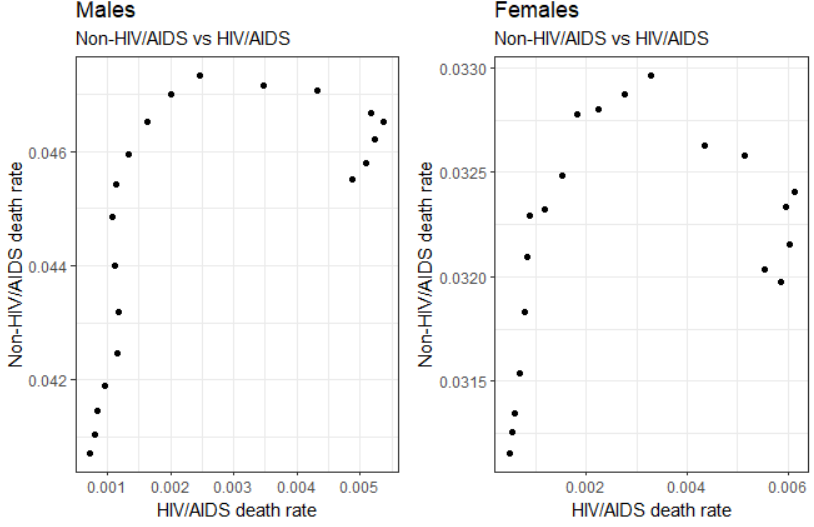
Figure 5. Joint distribution for non-HIV/AIDS and HIV/AIDS for males and females.